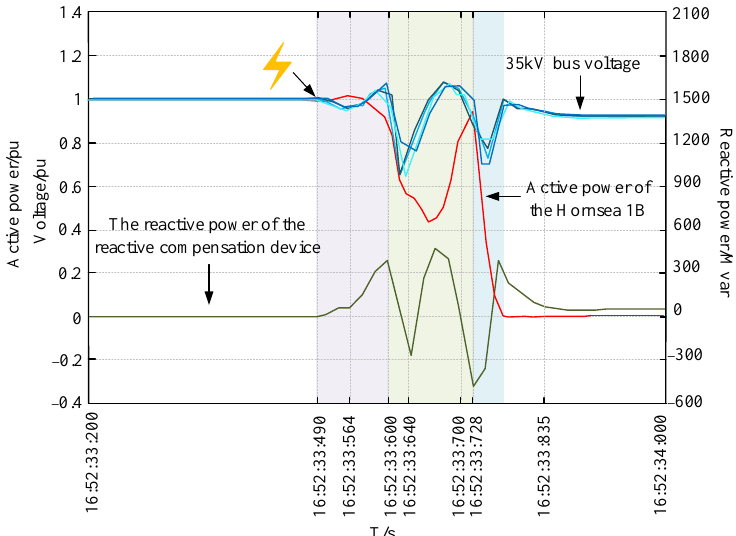
The reactive power of the reactive compensation device